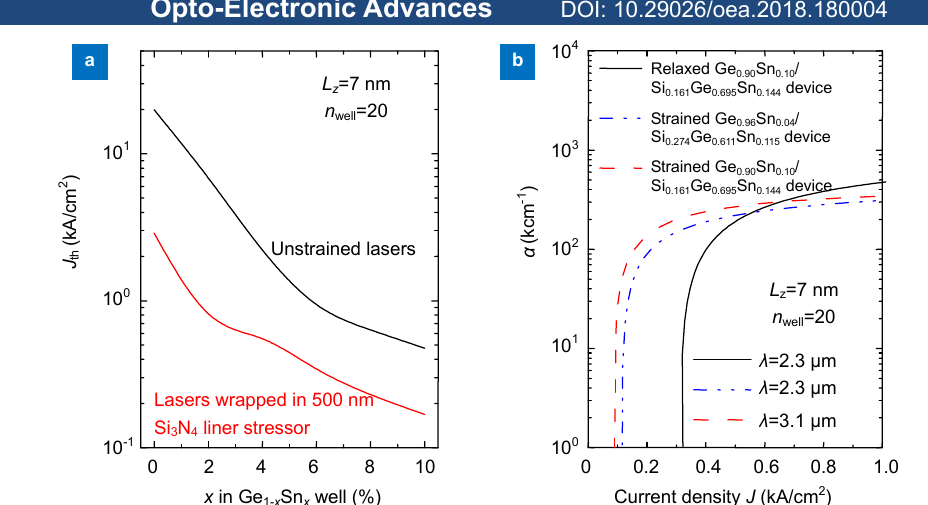
Fig. 9 | ( a ) Modeled J th as a function of the Sn composition in GeSn wells for relaxed and tensile strained GeSn/SiGeSn MQW lasers wrapped in a 500 nm Si 3 N 4 liner stressor. L z is 7 nm and n well is 20. ( b ) Modeled optical gain α as a function of injected current density J for the relaxed and tensile strained MQW lasers. Figure reproduced from ref. 36 , IEEE.